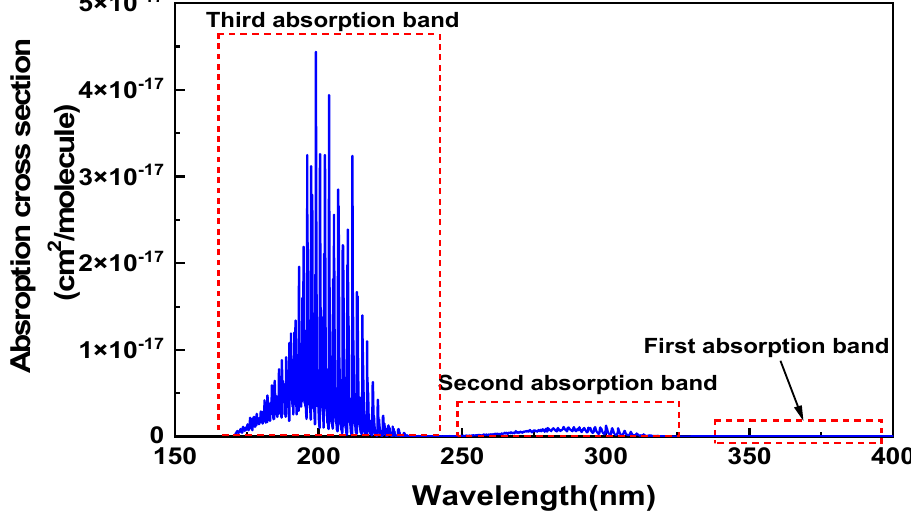
Figure 4. Absorption characteristics of SO 2 in the range from 180 nm to 400 nm.